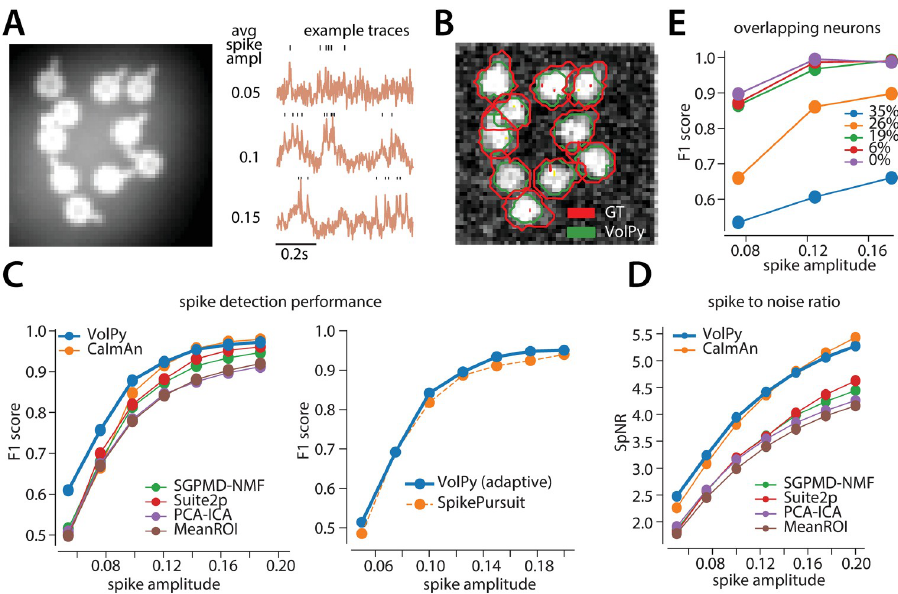
Fig 4. Evaluation of VolPy on simulated data. (A) Example of simulated data. Left. Average of movie across time. Right. Three example traces with different average spike amplitude. Higher spike amplitude are associated with higher signal to noise ratio. (B) The result of Mask R-CNN in segmenting the simulated movie (0.1 spike amplitude) laying over the correlation image. (C) Performance of VolPy , CaImAn , SGPMD-NMF, Suite2P, SpikePursuit, PCA-ICA and MeanROI on simulated data. Average F 1 score against ground truth in function of spike amplitude. (Left) All algorithms (including VolPy ) were evaluated with the optimal threshold. (Right) Comparison with SpikePursuit, adaptive threshold in both cases. (D) Spike-to-noise ratio (SpNR) in function of spike amplitude. (E) Evaluation of VolPy on overlapping neurons. Average F 1 score detecting spikes in function of spike amplitude and overlap between two neurons.